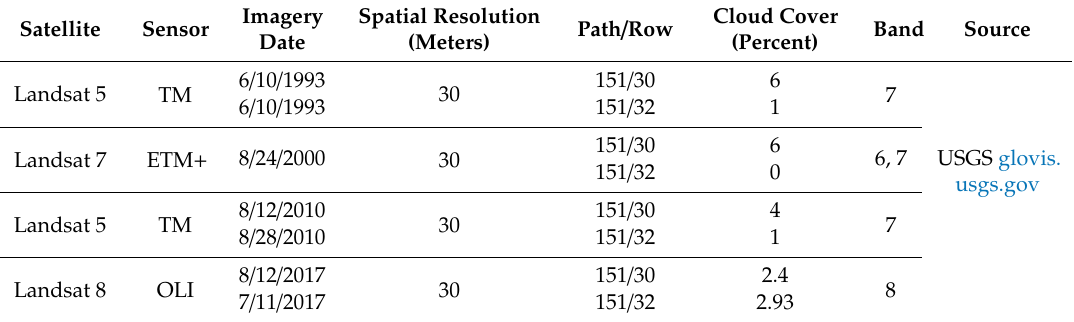
Table 1. List of Landsat data with their numbers of bands. Note: TM = Thematic Mapper; ETM + = Enhanced Thematic Mapper Plus; OLI = Operational Land Imager; USGS = United States Geological